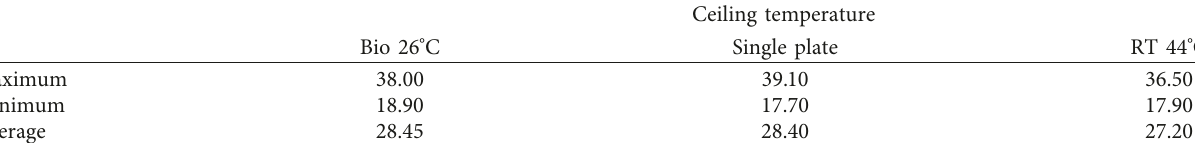
Table 7: Ceiling temperature measurement results of Test 1 ( ° C).